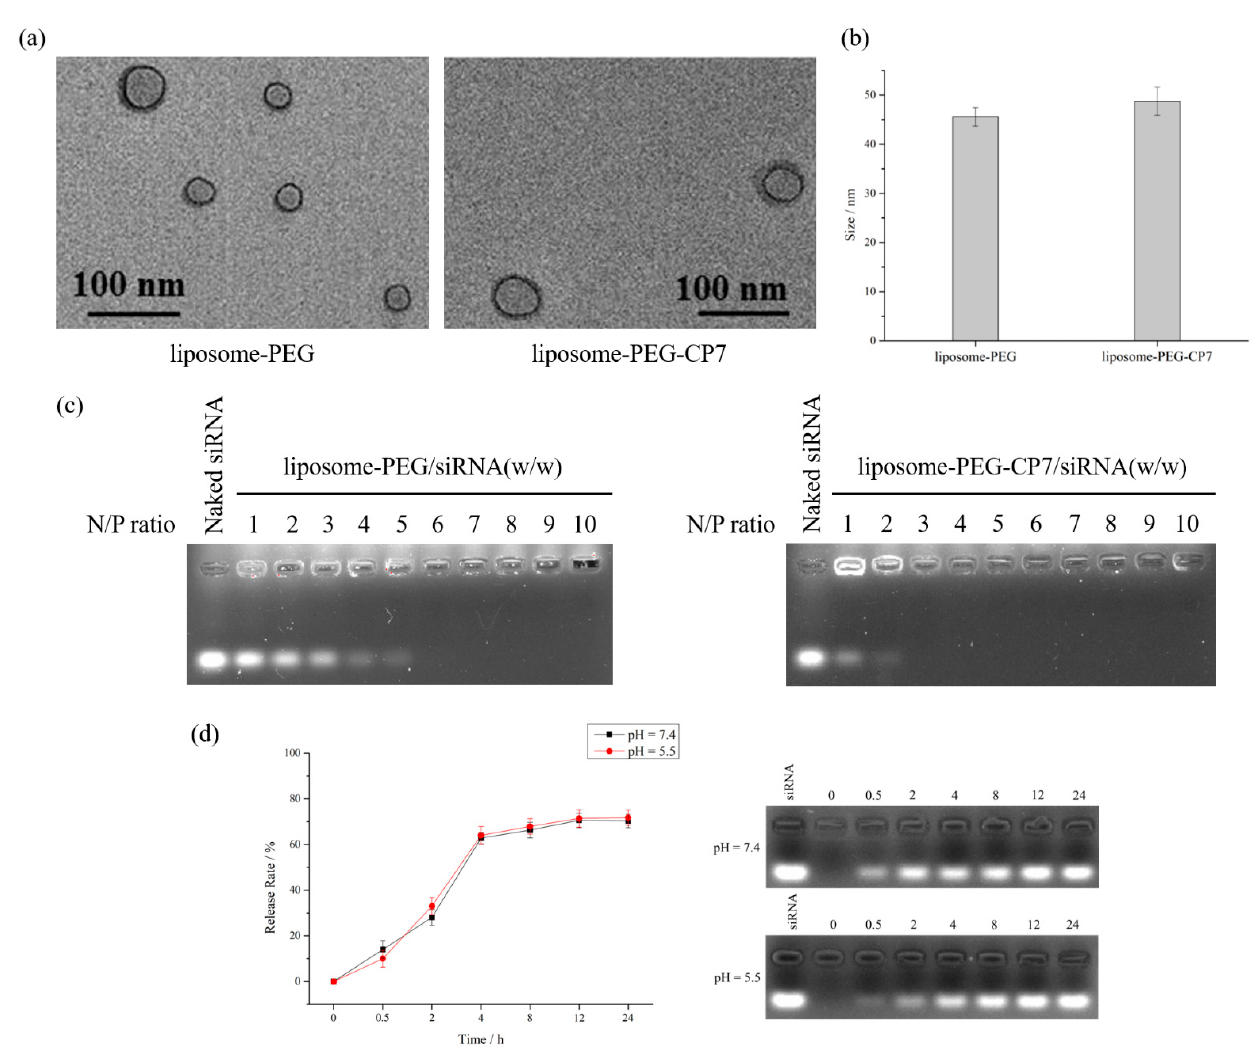
Figure 3. ( a ) TEM images of liposome-PEG and liposome-PEG-CP7. ( b ) Size distribution of liposome-PEG and liposome-PEG-CP7 by dynamic light scattering (DLS) analysis. Data are presented as means ± SD (n = 3). ( c ) siRNA binding ability of liposome-PEG and liposome-PEG-CP7 evaluated by agarose gel retardation assay. ( d ) Drug release profiles of liposome-PEG-CP7 in PBS at different pH. The right panel is a typical result of drug release assayed by agarose gel electrophoresis.